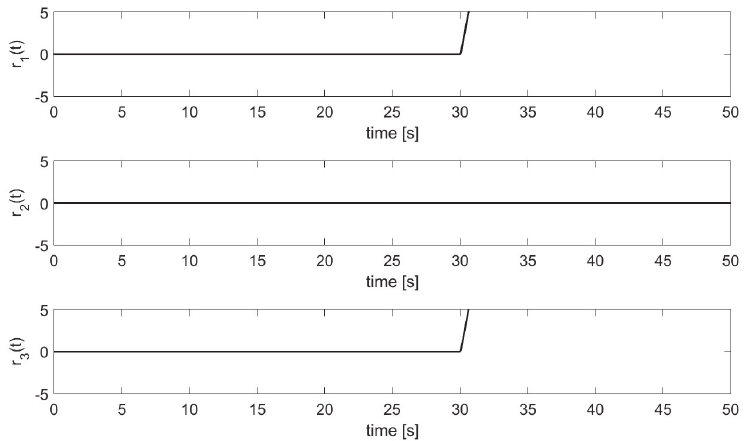
Figure 4. Response of residual to the fault f a 1